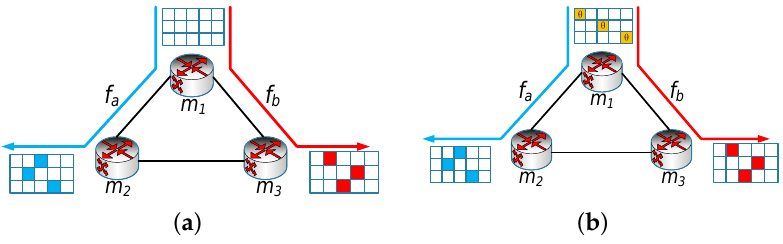
Figure 5. Two-stage online distribution algorithm (TODA). ( a ) First Stage; ( b ) Second Stage.